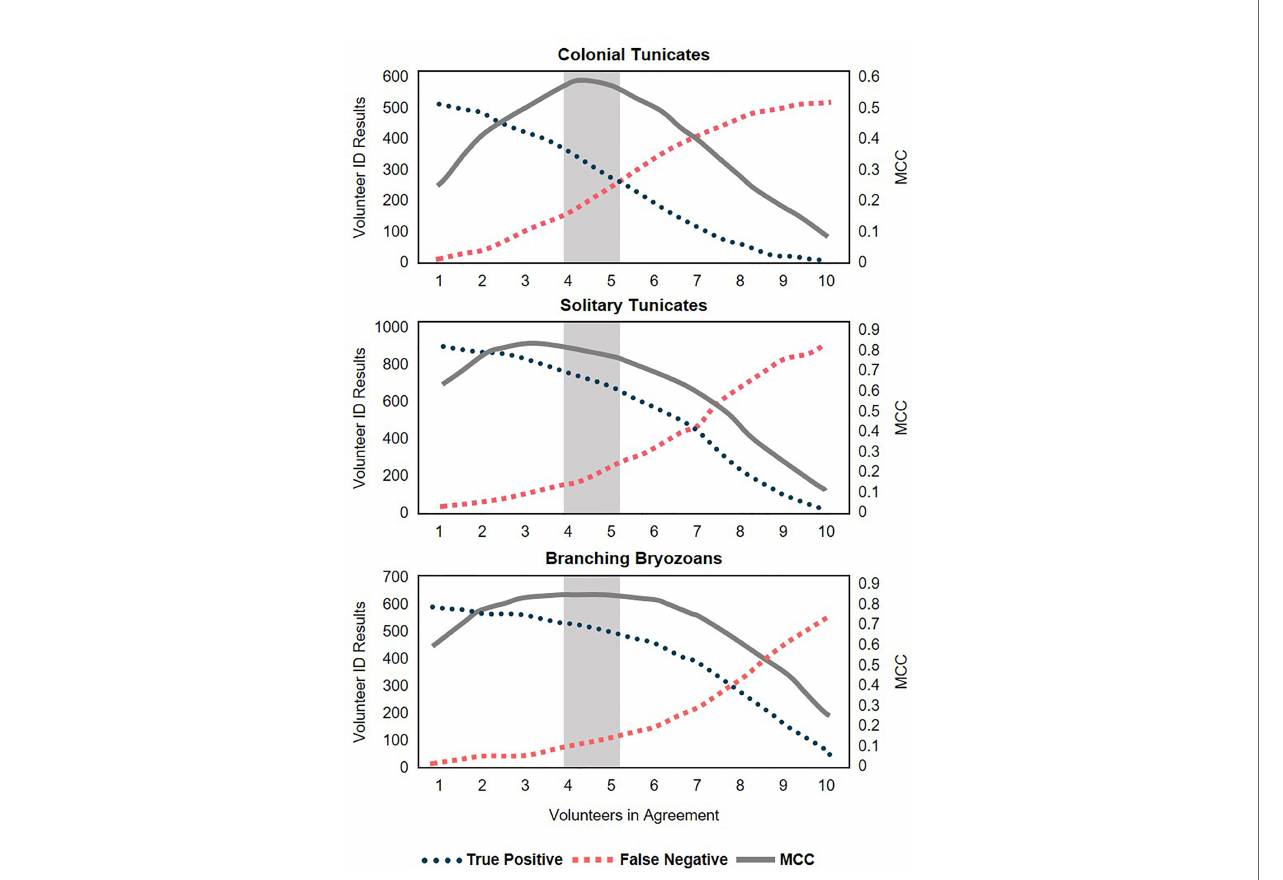
FIGURE 4 | Peak Mathew ’ s Correlation Coef fi cient (MCC) re fl ecting the trade-off between accuracy (highest number of true positives) and false negatives as more users are required to agree. Shaded area between two potential consensus methods of Four Agreed and Five